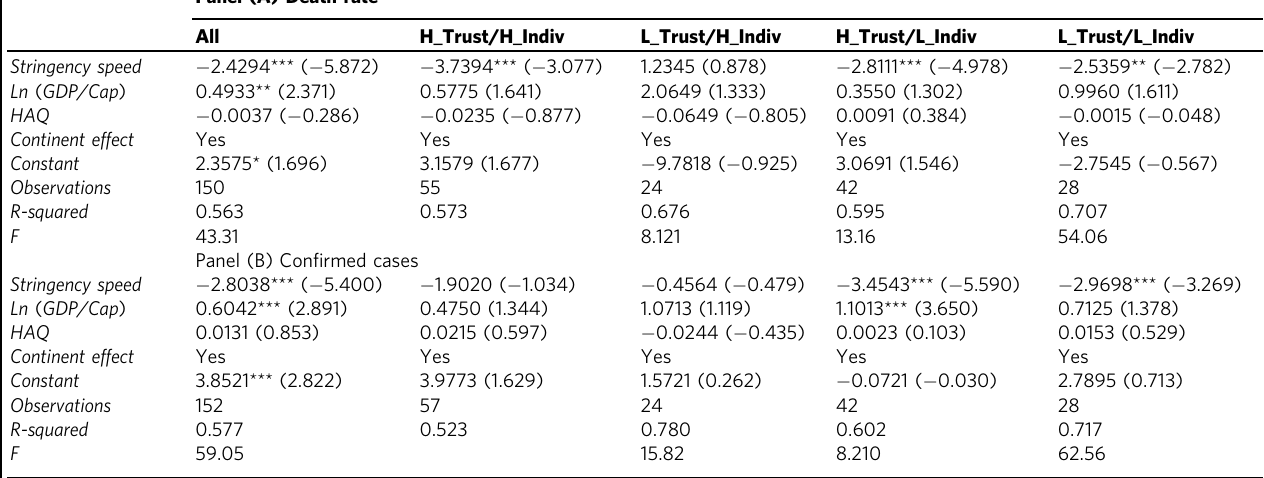
Table 5 Impact of the stringency speed on casualties and con fi rmed